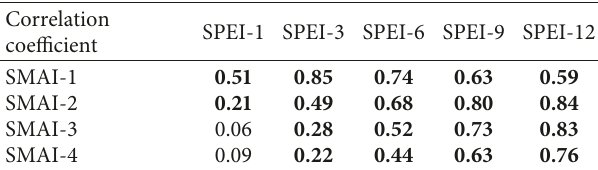
Note: r in bold indicates that it reached a significance level of α �